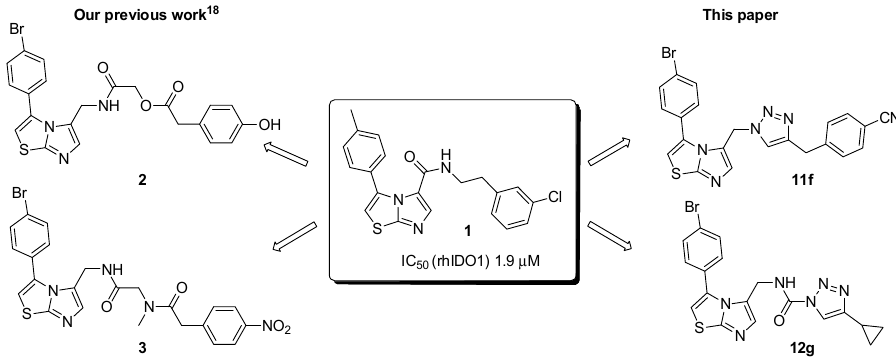
Figure 1. Structure of imidazothiazole compounds 1 , 2 , 3 , 11f and 12g .